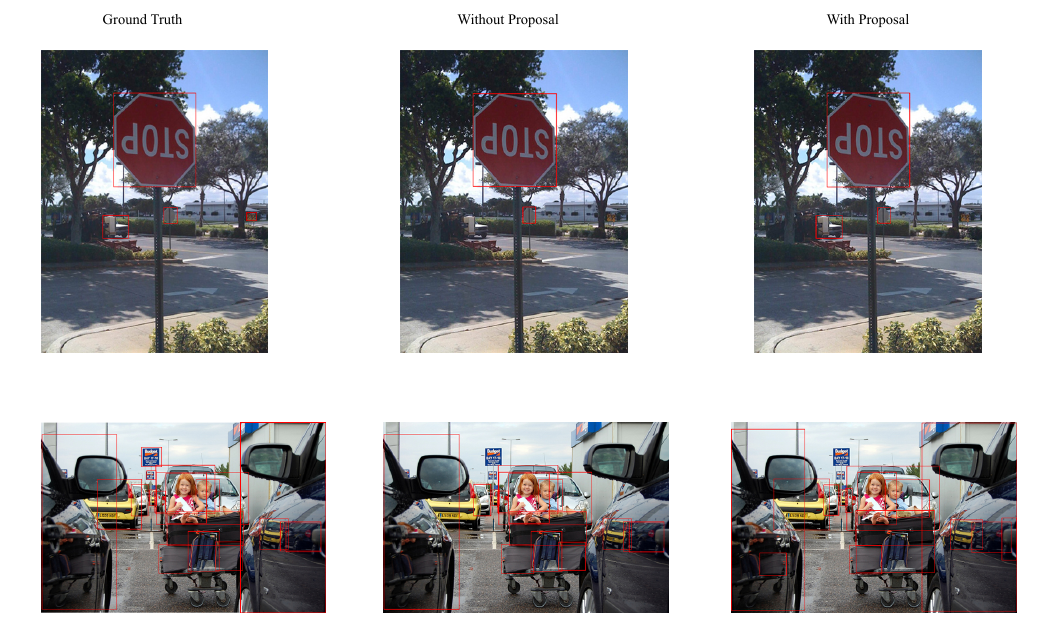
Figure 4. Comparison of visual